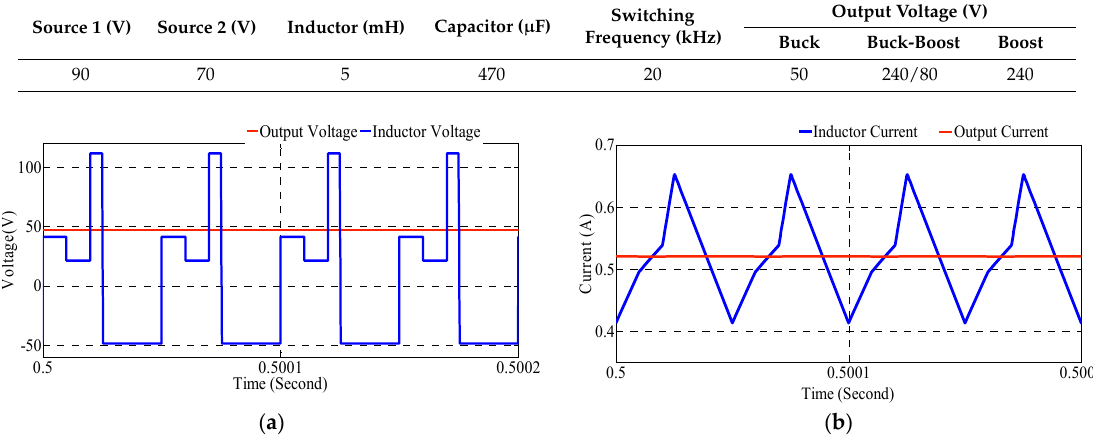
Figure 7. Simulation waveforms of the MBDC converter in buck operation: ( a ) Output voltage and inductor voltage; and ( b ) Output current and inductor current .